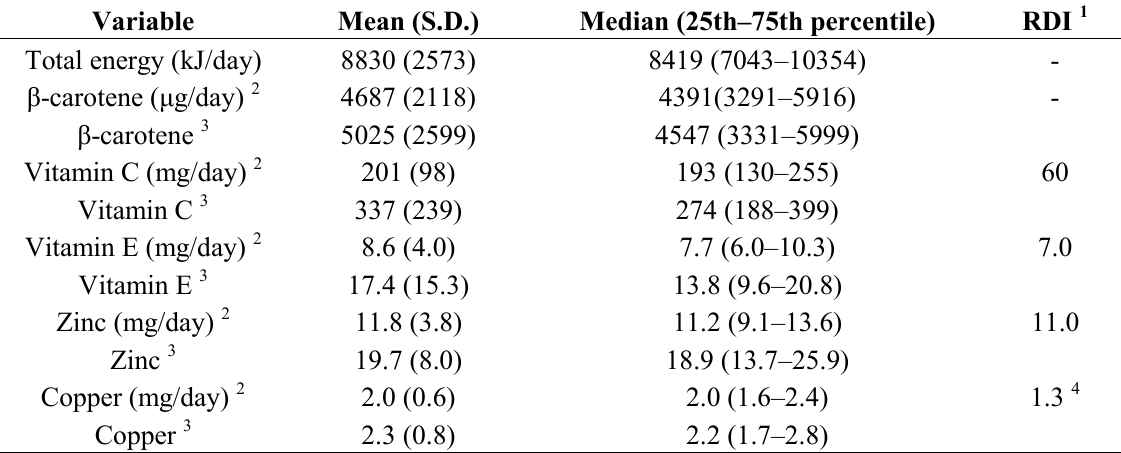
Table 2. Distribution of daily maternal dietary and total intakes of antioxidants in pregnancy.